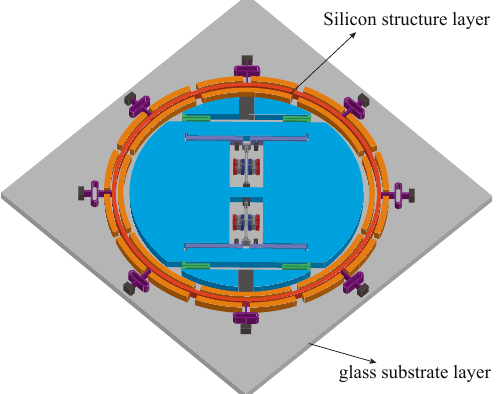
Figure 5. The whole structure of single-chip integrated accelerometer gyroscope (oblique